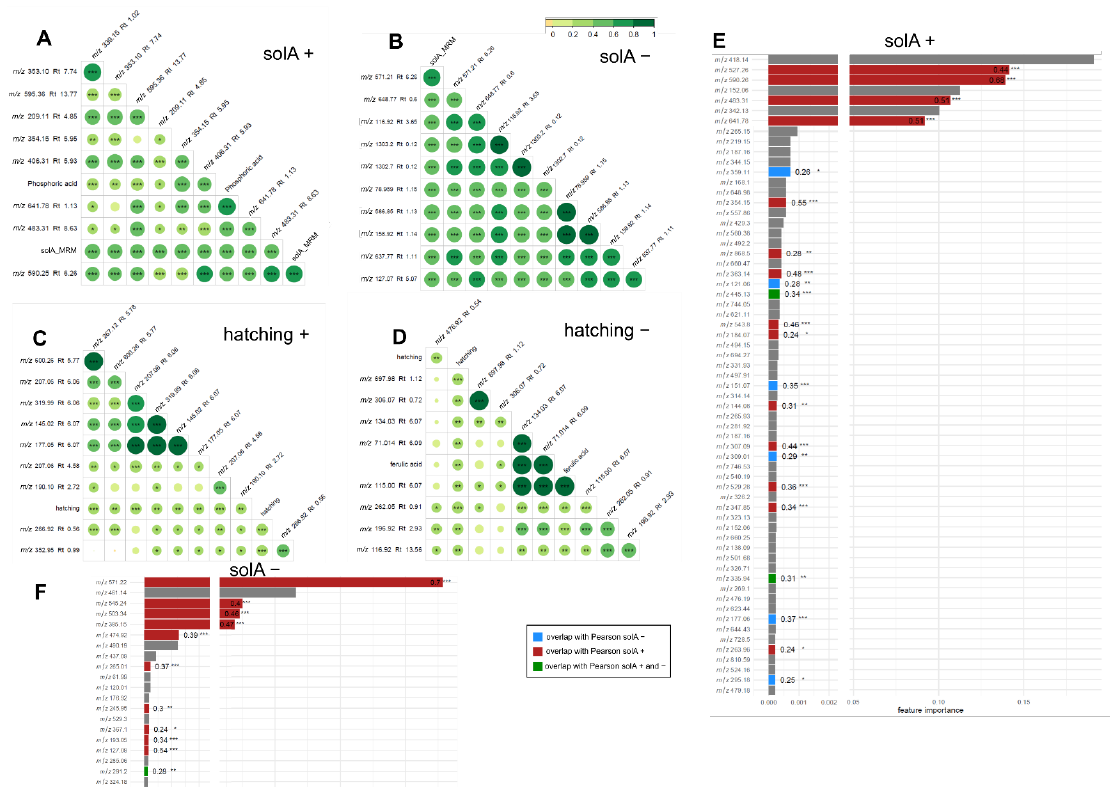
Figure 6. m / z values and retention times (Rt) of compounds in root extract samples detected by LC-ESI-QTOF-MS analysis that correlate with solA measured by UHPLC-multiple reaction monitoring-MS/MS (solA_MRM) ( A , C , D ) content and/or hatching ( B ), detected with Pearson’s correlation test ( A – D ) and Random Forest feature selection methods ( E , F ). ( A ) correlograms showing linear Pearson’s correlations of metabolites with solA_MRM in positive ( A ) and negative ( B ) mode. ( C , D ) correlograms showing linear Pearson’s correlations of metabolites with hatching in positive ( C ) and negative ( D ) mode. Order of the features in all correlograms is reordered according to the correlation coefficient using “hclust” method (corrplot package in R). ( E ) random forest feature selection for positive mode with solA_MRM. ( F ) random forest feature selection for negative mode with solA_MRM. The features that were as well detected with Pearson’s correlation analysis in the same mode (positive or negative) are marked in red. Features that were detected with Pearson’s correlation analysis in the opposite mode are marked in blue. Features that were detected with Pearson’s correlation analysis in the same as well as the opposite mode are marked in green. Their Pearson’s correlation coefficient is displayed in or next to the bar. The threshold for the Pearson’s correlation coefficient was 0.1. Only statistically significant ( p < 0.05) Pearson’s correlations are marked. The degree of significance is marked by stars: p < 0.001, ***; p < 0.01, **, p < 0.05,